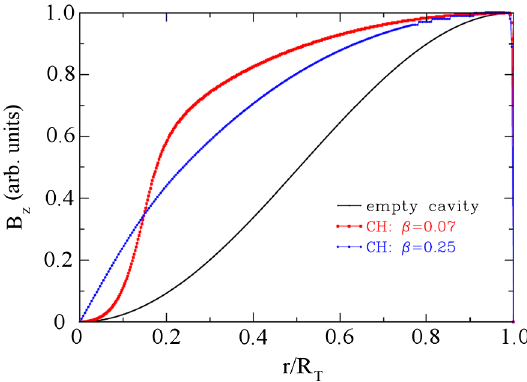
FIG. 9. Schematic view of a CH structure used for the analyti- for an empty cavity ( H mode) and z 211 cal model.